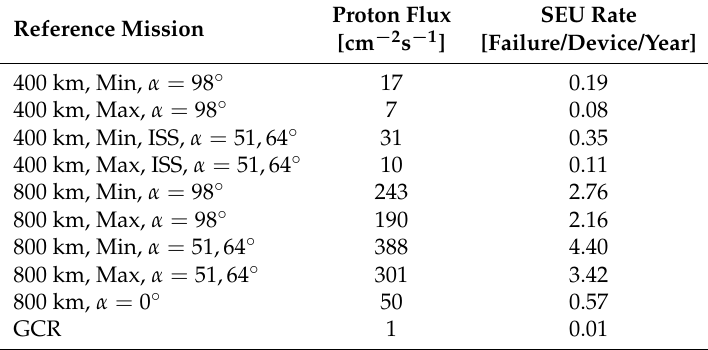
Table 13. SEU event rates for considered reference missions.